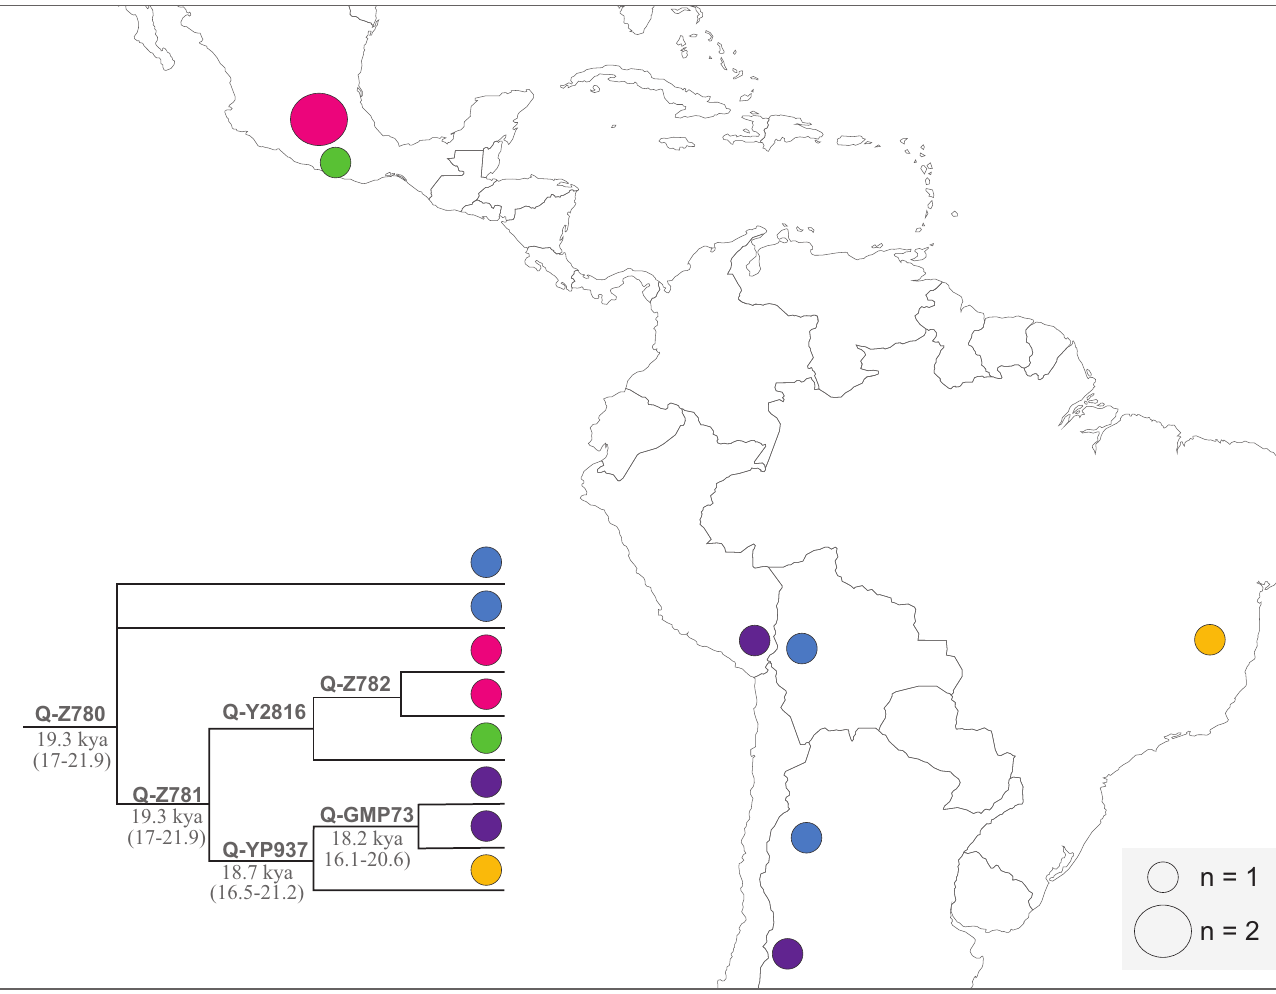
Fig 2. Schematic representation of the geographic distribution of Q-Z780 and sub-lineages. Colored circles represent geographic distribution and sub-lineage membership as shown in the inset tree. Divergence times estimated in this study are represented in italics, in kya, and with a 95% confidence interval between parentheses (for more details see Methods). The size of the circles is related to the number of subjects and is specified with the "n" in the box to the right. Individuals with Mexican ancestry from Los Angeles have been arbitrarily represented in City of Mexico (for more information about samples, see S1 Table). Layer map downloaded from